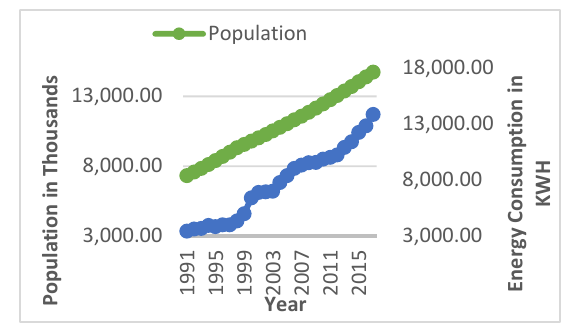
Fig. 8: Relationship of Population and Energy Consumption Urbanization and Climate Change: The average Fig. 6: Average Annual Energy Consumption of Commercial annual climate of Karachi has been increased by 3 ̊ C Buildings (Source: K.E) from the year 1948-2017 (Fig. 9). The highest average temperature was in the year 1999 because of the minimum amount of precipitation which has been shown in Fig. 10. The temperature and precipitation has inverse relationship as shown in the Fig. 10. The highest temperature was recorded in the year in which the minimum amount of precipitation recorded.